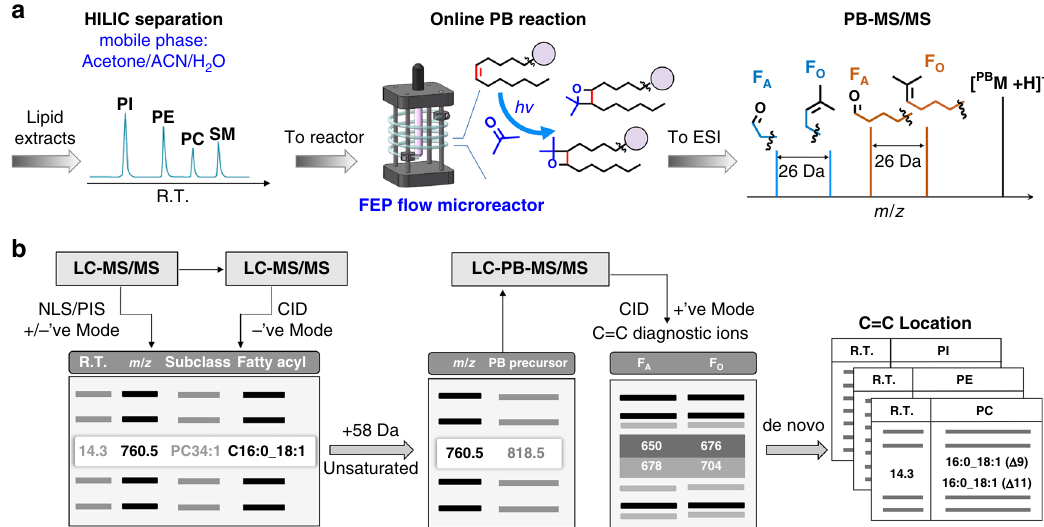
Fig. 1 Schematic of the LC – PB – MS/MS system for lipid identi fi cation at C = C location level. a The key components include lipid class separation on a HILIC column employing acetone/ACN/NH 4 Ac (10 mM) aqueous solution as mobile phase, a fl ow microreactor made from FEP tubing and a low-pressure mercury lamp (emission at 254 nm wavelength) for online coupling with LC and ESI – MS, and formation of C = C diagnostic ions via CID of the PB products of unsaturated GPs (PB – MS/MS). b The analysis work fl ow consists of two conventional LC – MS/MS runs for lipid identi fi cation at fatty acyl level and data dependent LC – PB – MS/MS for lipid identi fi cation at C = C location level. Data analysis was conducted using a home-developed program, Lipid Omega